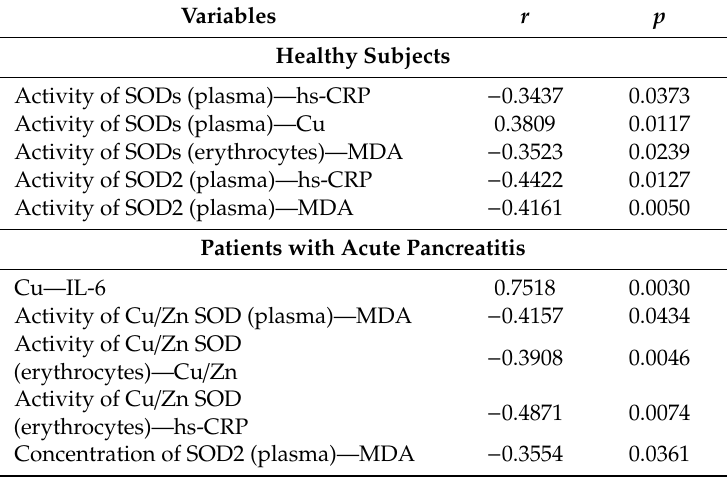
Table 5. Correlation coe ffi cients for the group of healthy subjects and AP